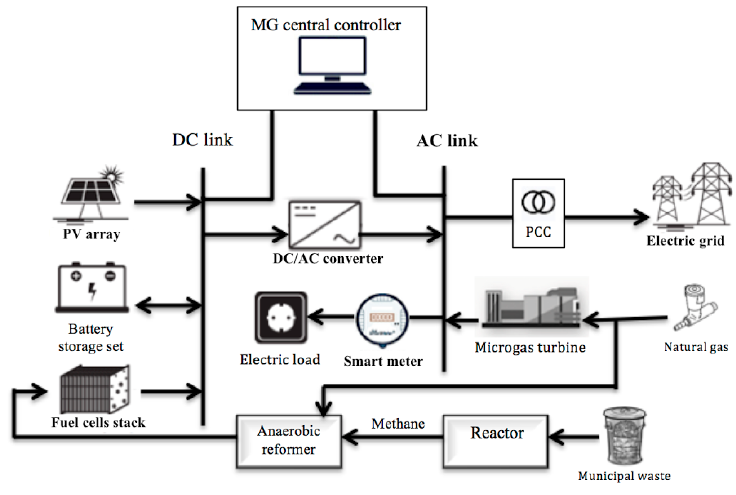
Figure 1. Schematic of a grid-connected microgrid with various distributed energy resources (DERs).